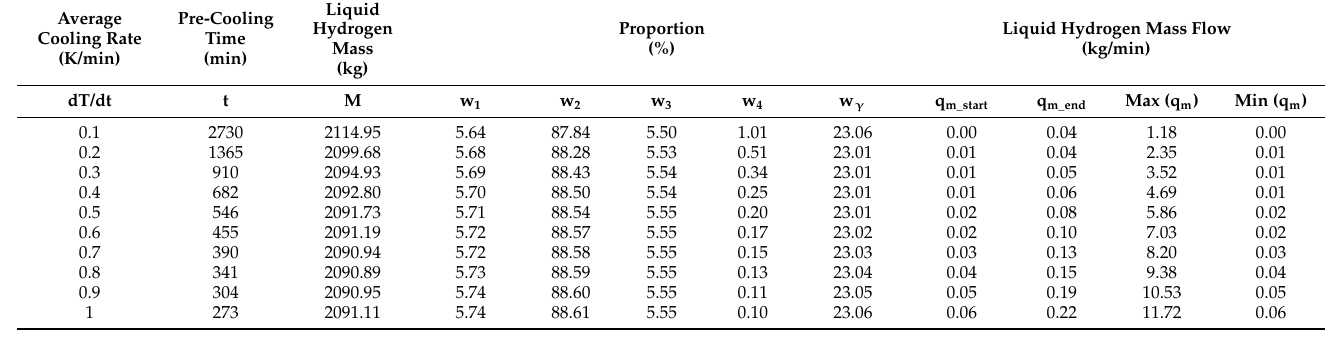
Table 2. Pre-cooling process parameters at different cooling rates.